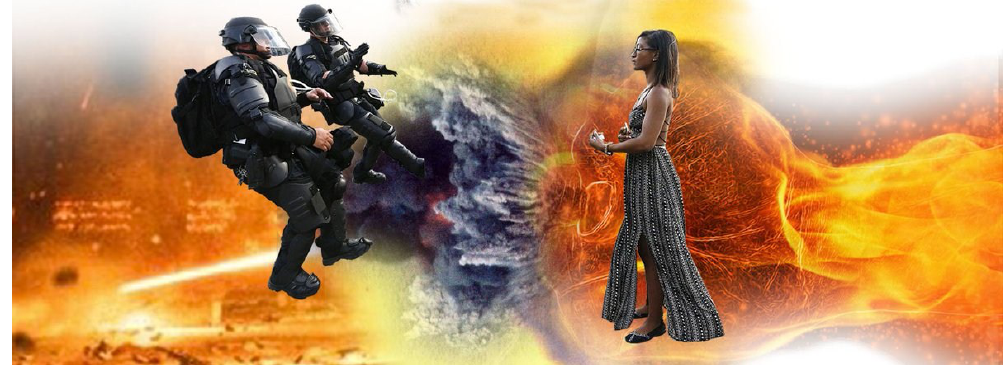
Figure 11. The supernatural effect of touching Evans (2016). By Zack Sande. Picture courtesy of the artist.